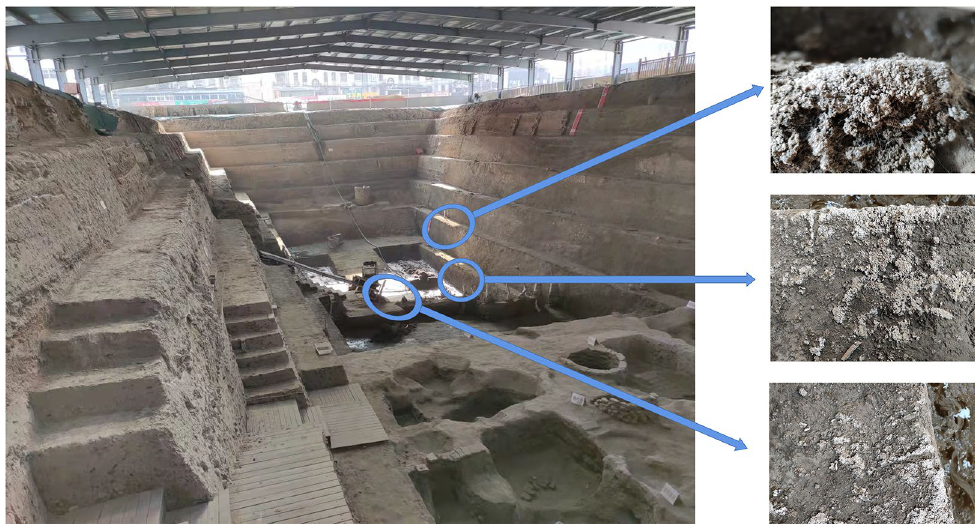
Figure 1. Present situation and salt damage of Zhouqiao site.